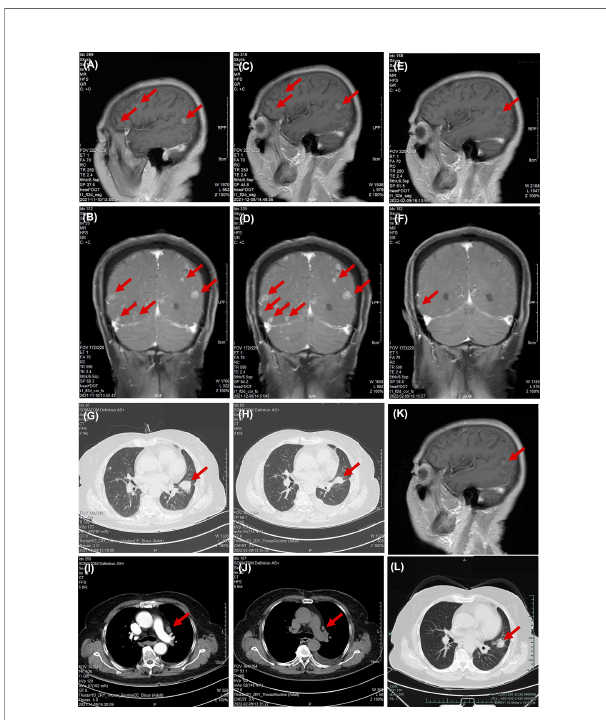
FIGURE 2 | Responses of EGFR TKIs as third- and fourth-line therapy. Chest scanning CT before and after EGFR TKI treatment: (A, B) Brain MRI before ge fi tinib on November 10, 2021. (C, D) Brain MRI after ge fi tinib on December 8, 2021. (E, F) Brain MRI after almonertinib on February 9, 2022. (G, H) Chest CT scan before ge fi tinib on November 10, 2021. (I, J) Chest CT scan after almonertinib on February 9, 2022. (K, L) Chest CT and brain MRI 4